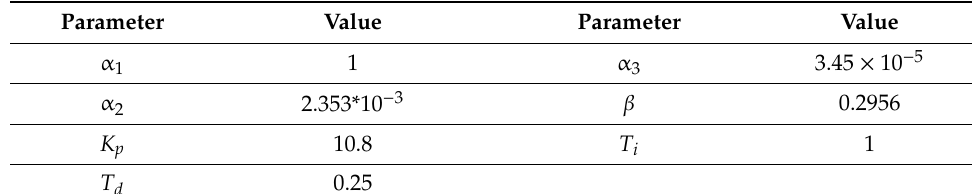
Table 2. Parameters in the model and PID controller.